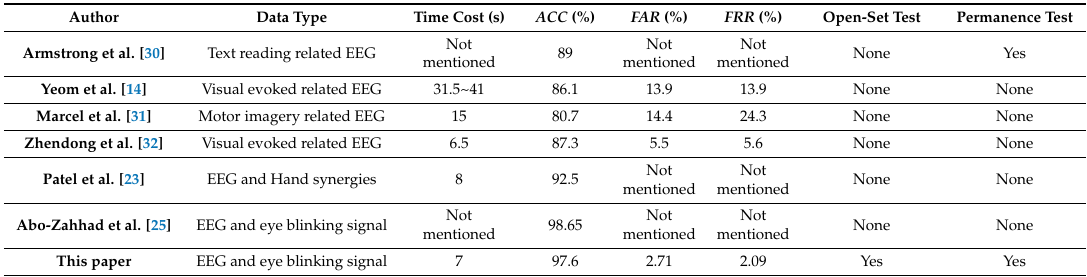
Table 5. Performance comparison of the previous